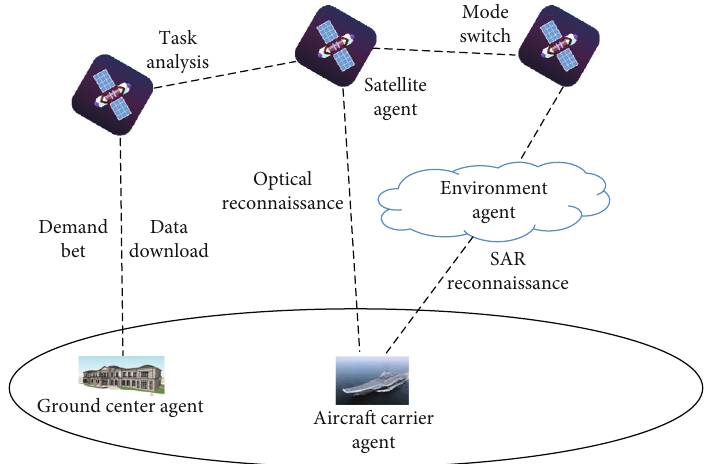
Figure 10: Agent model of the whole process of task